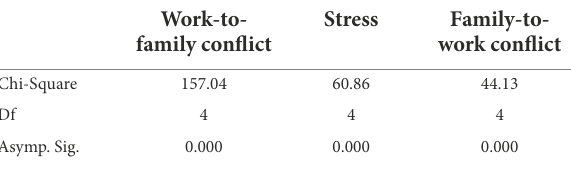
TABLE 6 One-sample Kolmogorov–Smirnov test.